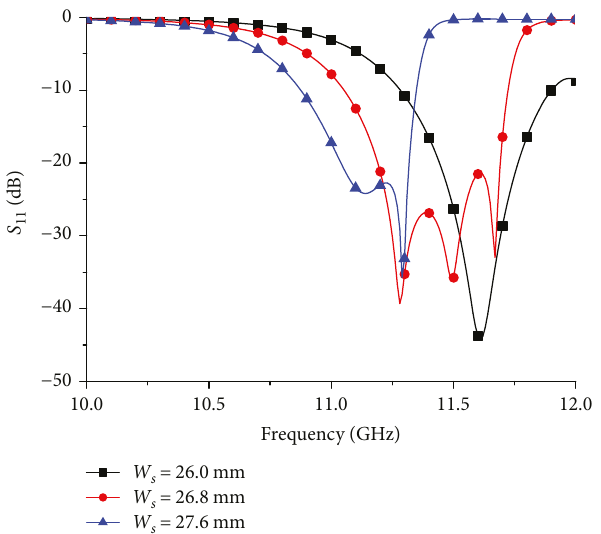
Figure 7: The scattering parameters versus frequency with variable S ( W =26.8mm, W c s